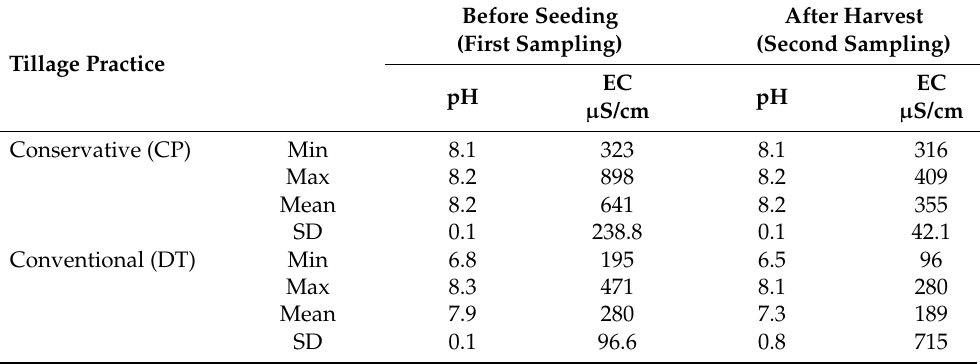
Before Seeding (First